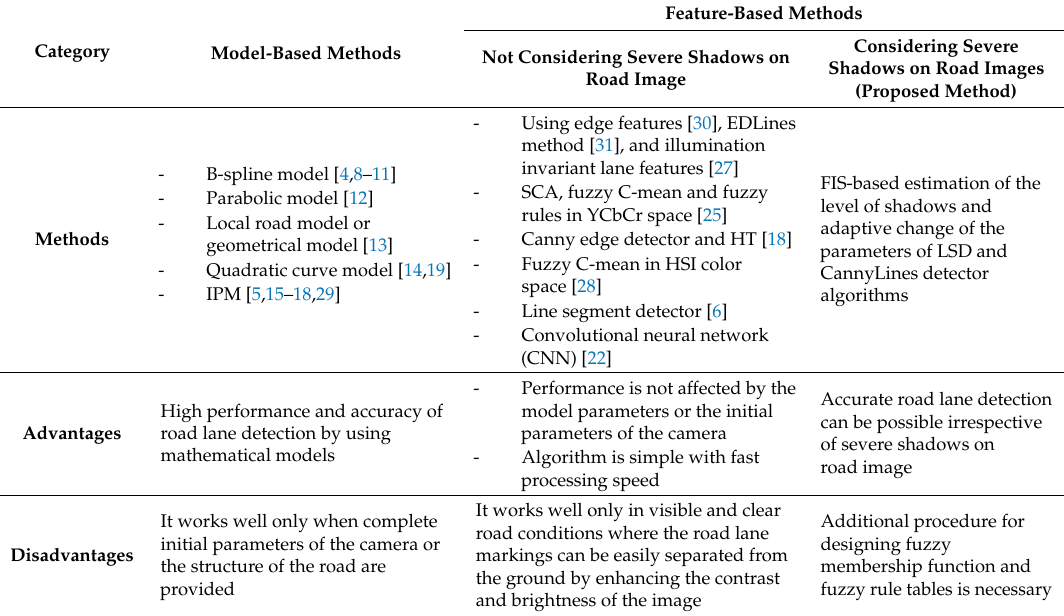
Table 1. Comparisons of previous and proposed methods on road lane